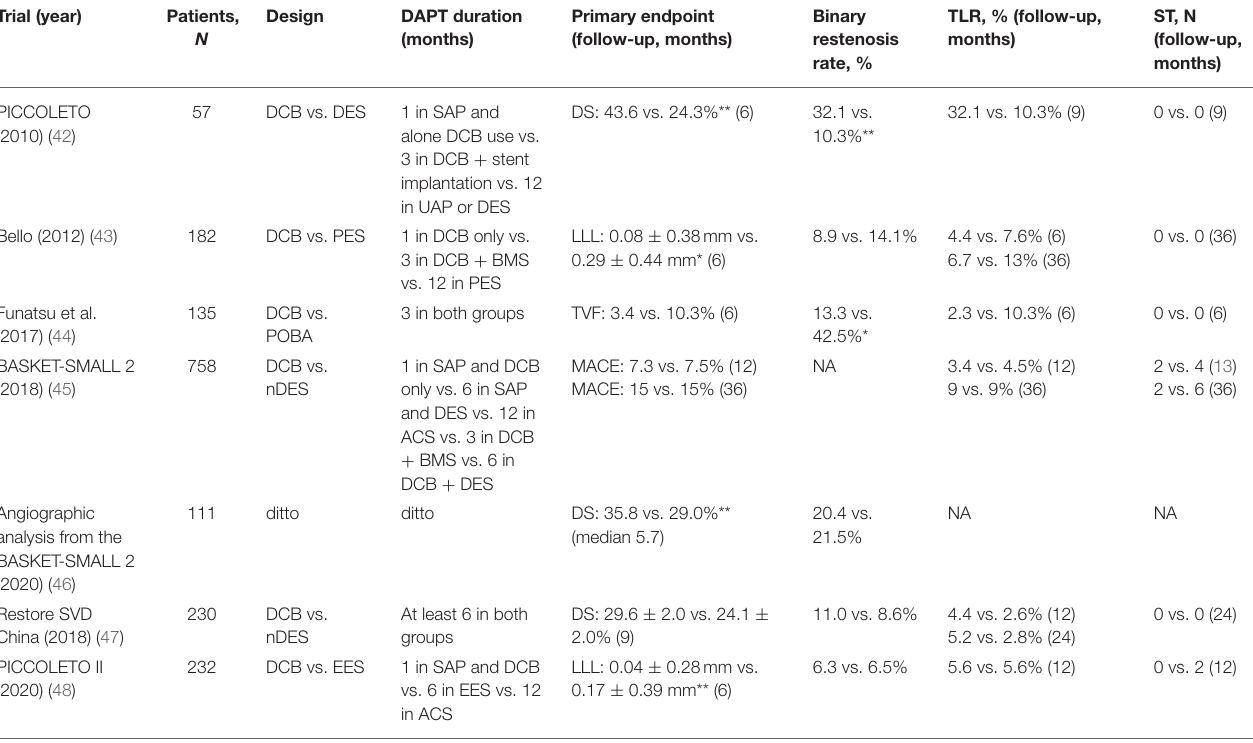
Trial (year) Patients,